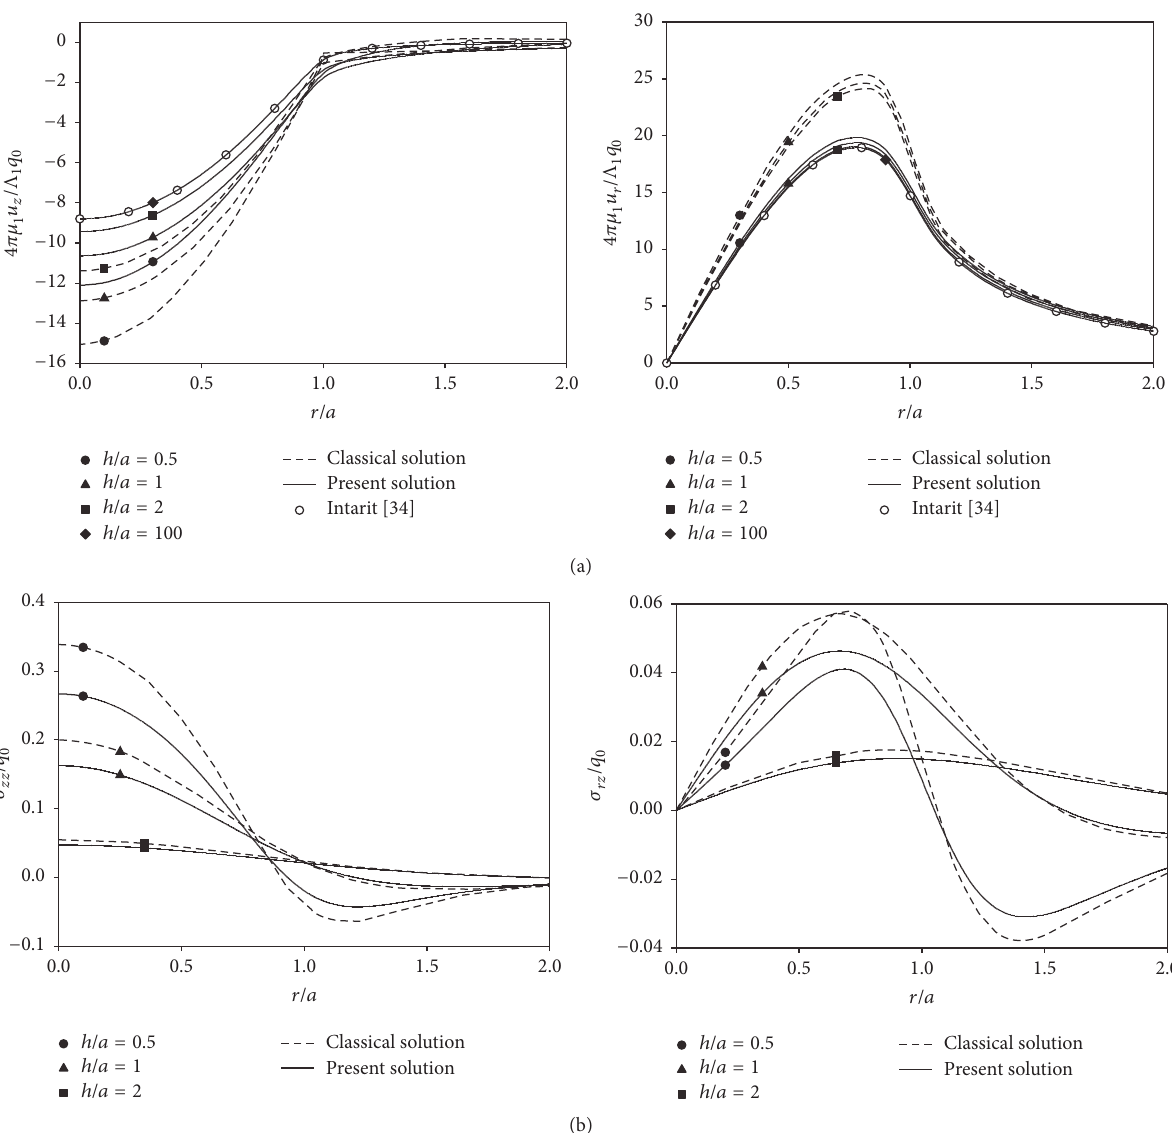
larger loading area would produce higher displacements and